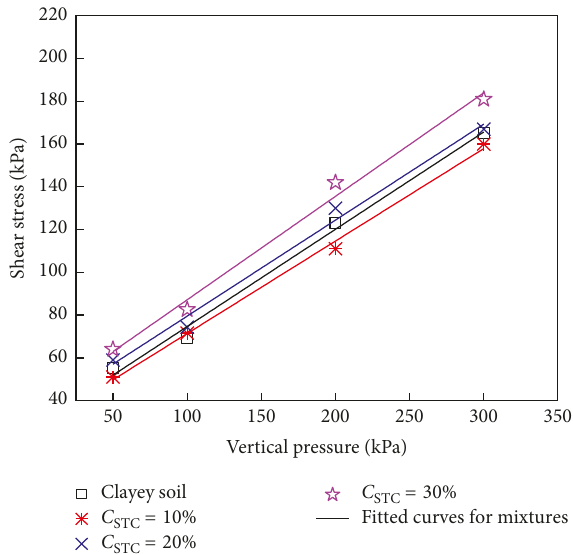
Figure 6: Mohr–Coulomb failure envelopes for